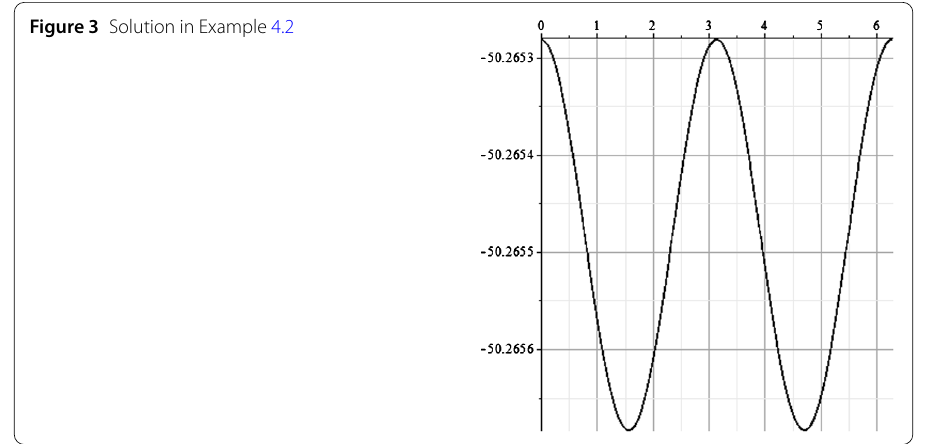
Figure 3 Solution in Example